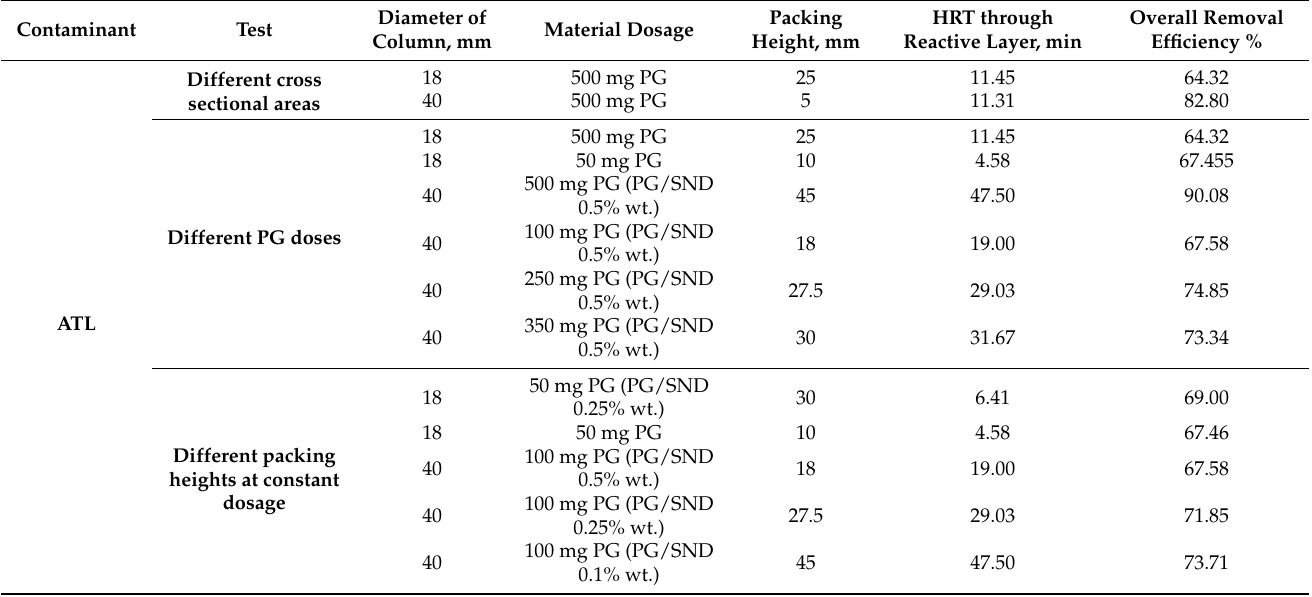
100 mg PG (PG/SND 0.1%